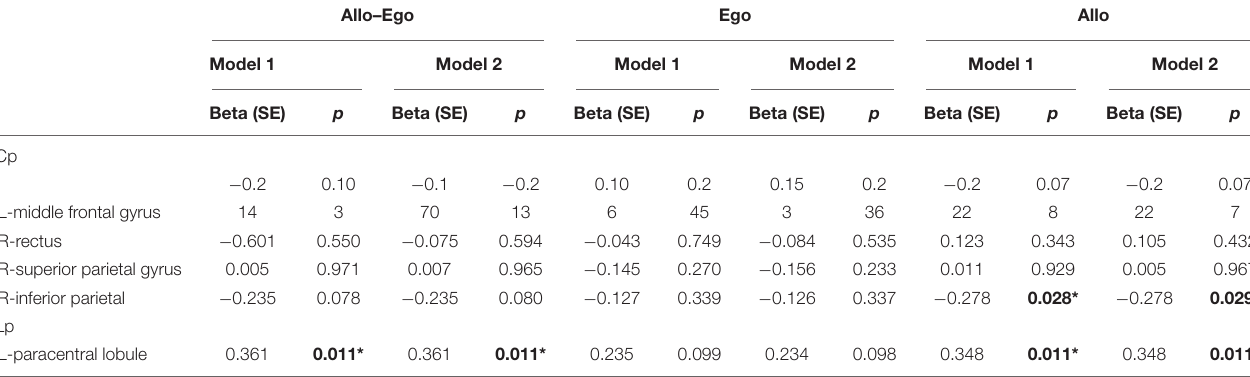
TABLE 4 | General linear regression analyses between nodal network topology properties and spatial navigation accuracy. Allo–Ego Ego